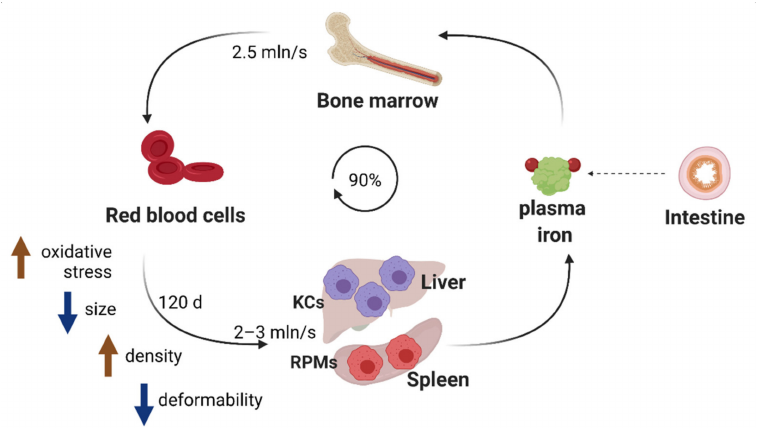
Figure 1. Iron recycling ensures the turnover of the body iron pool. Approximately 90% of iron needs for erythropoiesis are met by internal iron recycling from aged red blood cells. This task is accom- plished by macrophages, predominantly Kupffer cells (KCs) in the liver and red pulp macrophages (RPMs) in the spleen. When erythrocytes age (in approximately 120 days in humans), their elasticity is reduced, which mediates their trapping in iron-recycling organs and further engulfment by KCs and